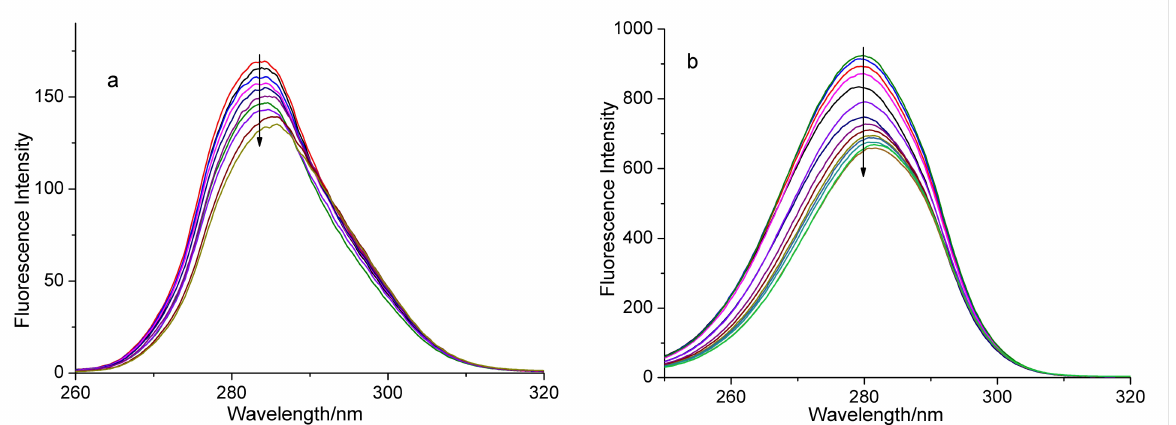
Figure 5. Synchronous fluorescence spectra of BSA in the presence of increasing amounts of complex 1 at ∆ λ = 15 nm ( a ) and at ∆ λ = 60 nm ( b ). The arrows show the emission intensity changes upon the increasing concentrations of complex 1 .